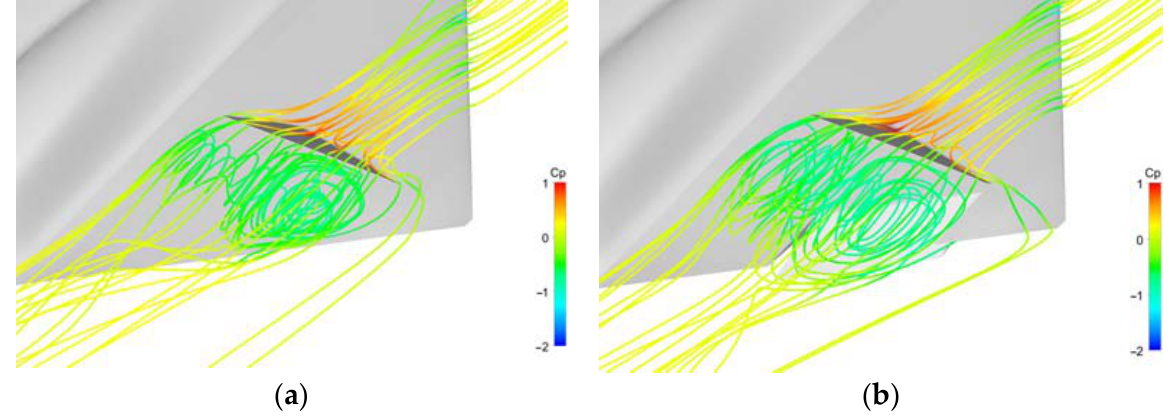
Figure 14. Spatial streamlines around the SSD3 and the corresponding FCR, Ma = 0.2, Re = 3.98 × 10 7 ,